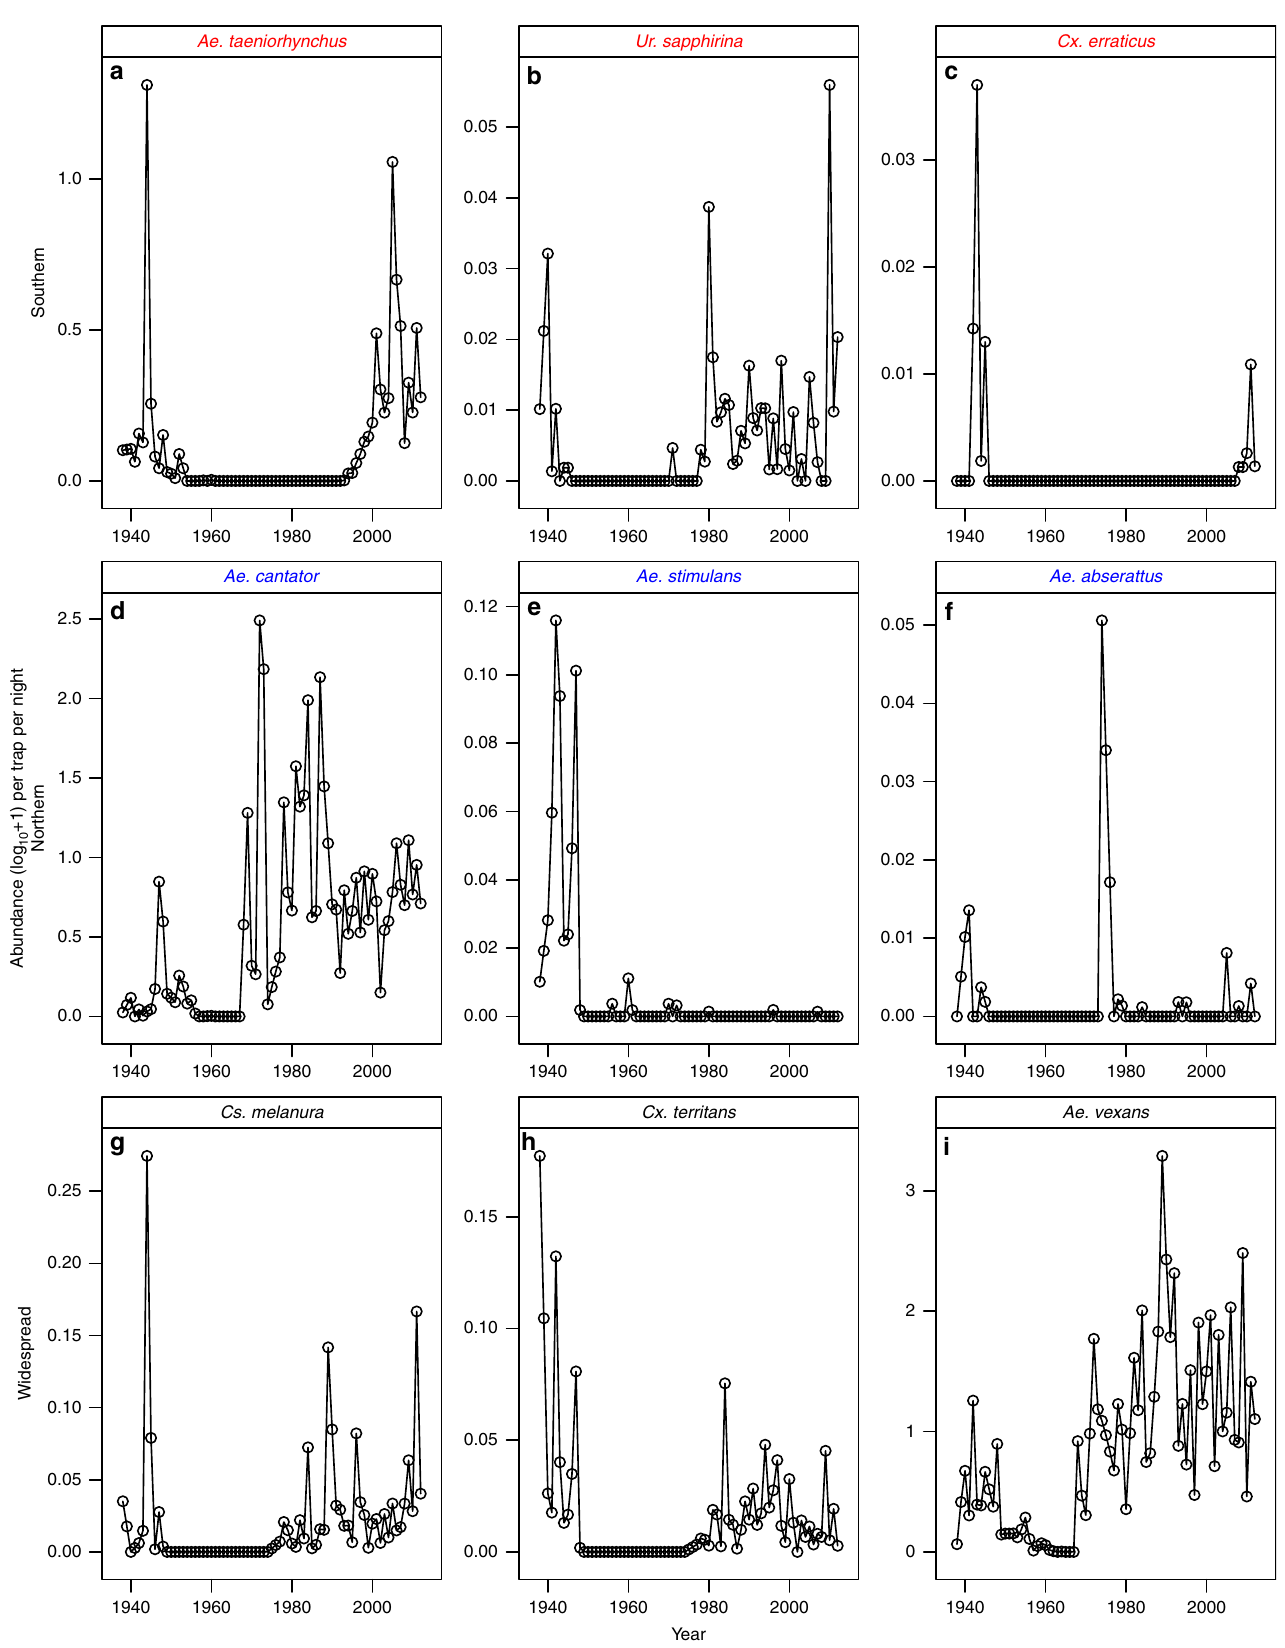
Figure 8 | Abundance of representative mosquito species over time in New York. Panels show average number of female mosquitoes collected per trap per night. Southern species (panels a – c ) with names in red. Northern species, (panels d – f ) with names in blue. Widespread species (panels g – i ) with names in